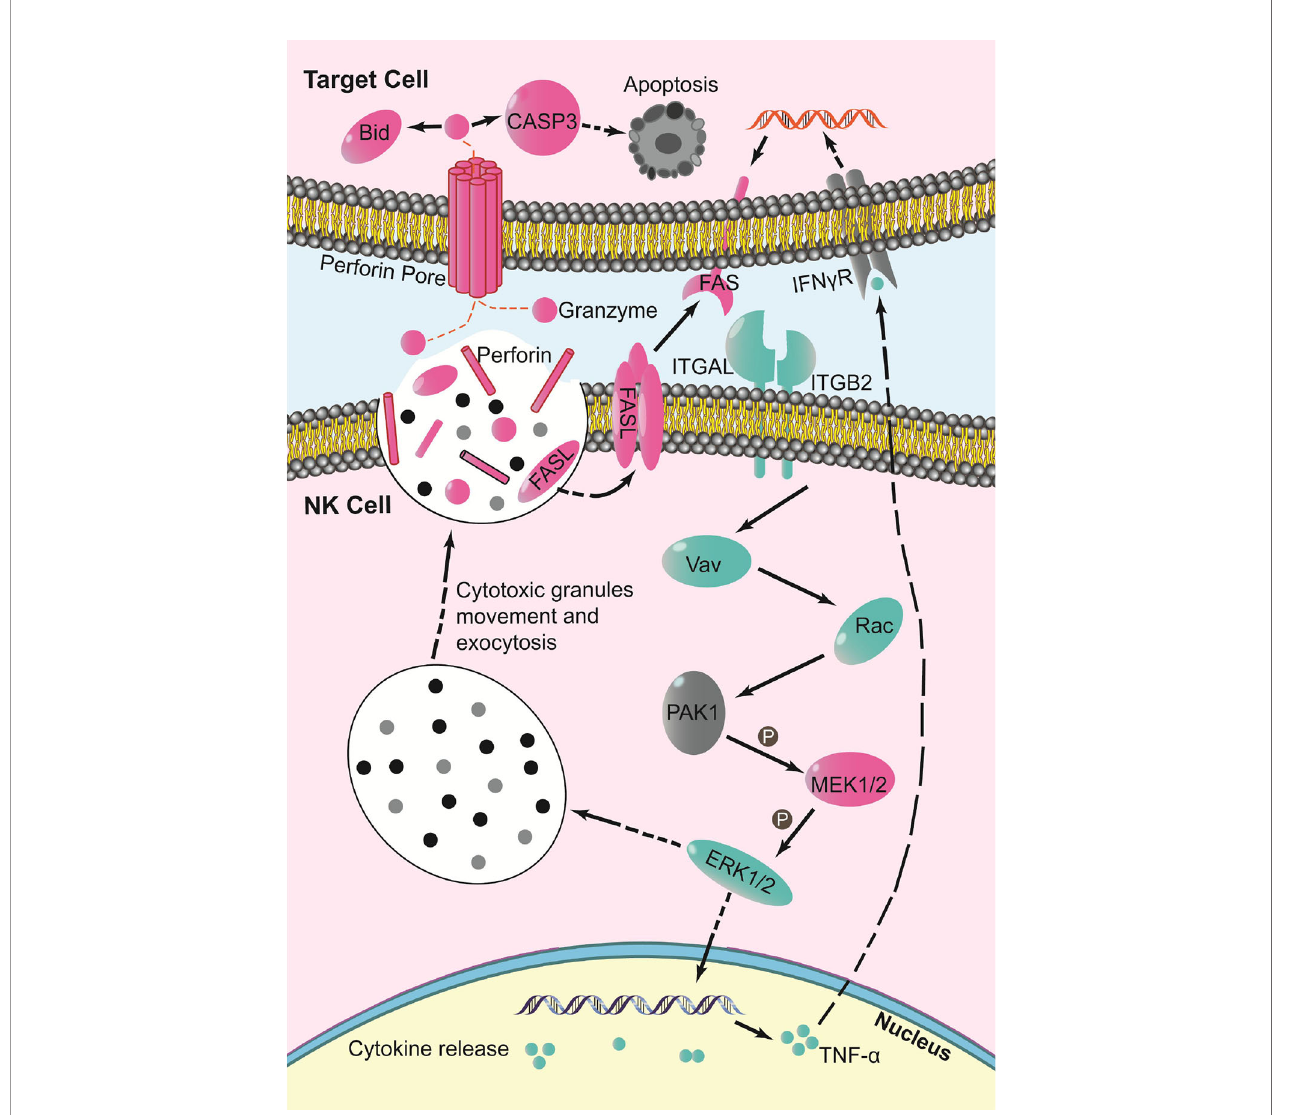
FIGURE 7 | Schematic of key changes in NK cell-mediated cytotoxicity pathway (blue indicates down-regulation, red indicates up-regulation, gray indicates no signi fi cant change, P indicates